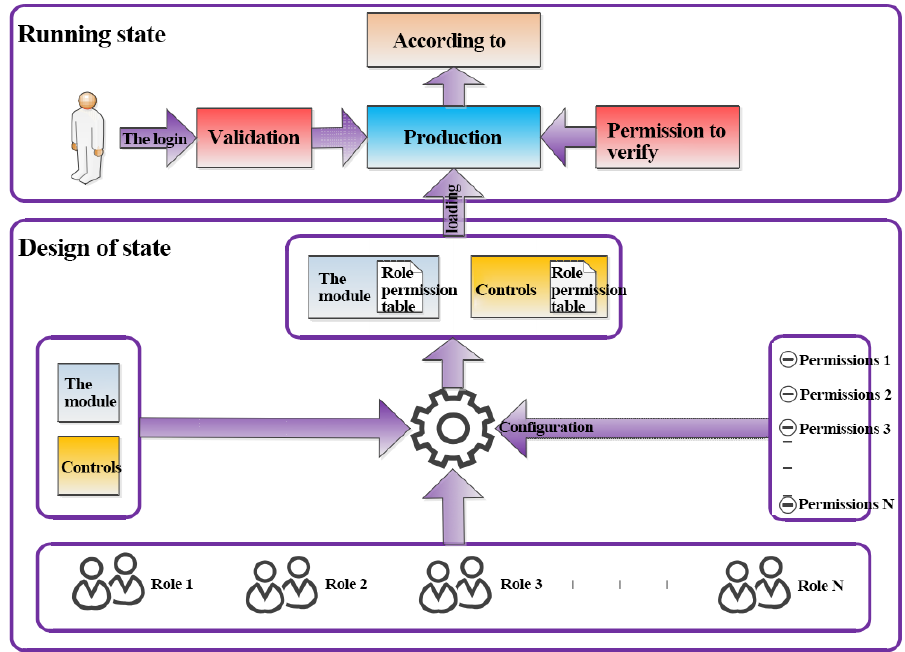
Figure 9. Privilege configuration